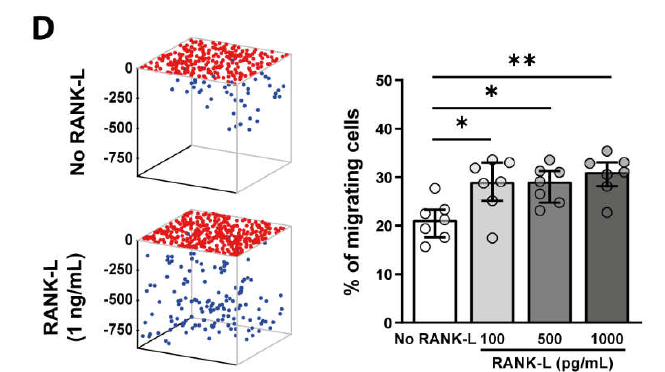
Figure 4. RANK-L is secreted by HIV-1-infected MF and promotes 3D migration of OC precursors. ( A ) MF were infected with HIV-1 (HIV-MF, NLAD8 strain) for 7 days, and the level of released RANK-L was measured by ELISA in the supernatant and compared to uninfected MF (NI-MF) from the same donor. n = 5. ( B ) Monocytes were di ff erentiated for 3 days in presence of sub-optimal concentrations of RANK-L and then exposed to the supernatant of infected (CmHIV) or uninfected (CmNI) MF for additional 10 days. Cells were then fixed and the fusion index was quantified by IF. Bars represent median, n = 6 donors. ( C , D ) CmHIV or CmNI pre-treated or not with OPG (100ng / mL) ( C ), or di ff erent concentrations of recombinant RANK-L ( D ) was added at the bottom of 3D Matrigel matrices. OC precursors were then seeded at the top of the matrices and allowed to migrate. Left: 3D representation of the positions of OC precursors that have migrated (blue dots) or not (red dots) in a representative migration assay. Ticks represent depth in microns. Right: quantification of the percentage of cells inside the matrix. ( C ) n = 4 donors; ( D ) n = 7 donors, performed in triplicates. Histograms represent median and error bars are interquartile range. * p ≤ 0.05; ** p ≤ 0.001, ns: not significantly di ff